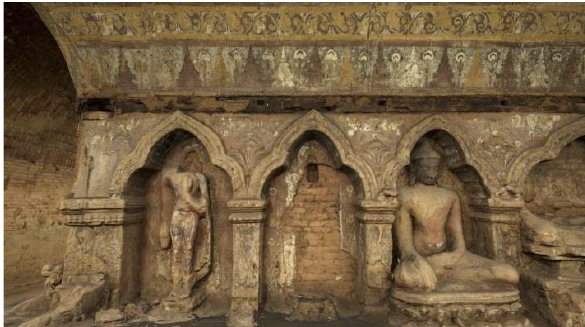
Figure 10. Photogrammetric model of Myin-pya-gu interior sculptures.